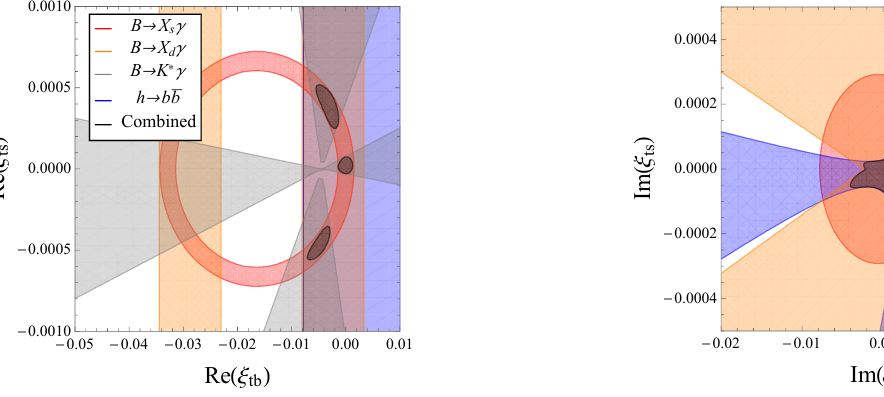
Figure 11 . The left (right) panel shows the constraints on the real (imaginary) parts of (cid:24) tb and (cid:24) ts . These limits assume that only the real or imaginary parts of (cid:24) tb and (cid:24) ts are generated at the scale